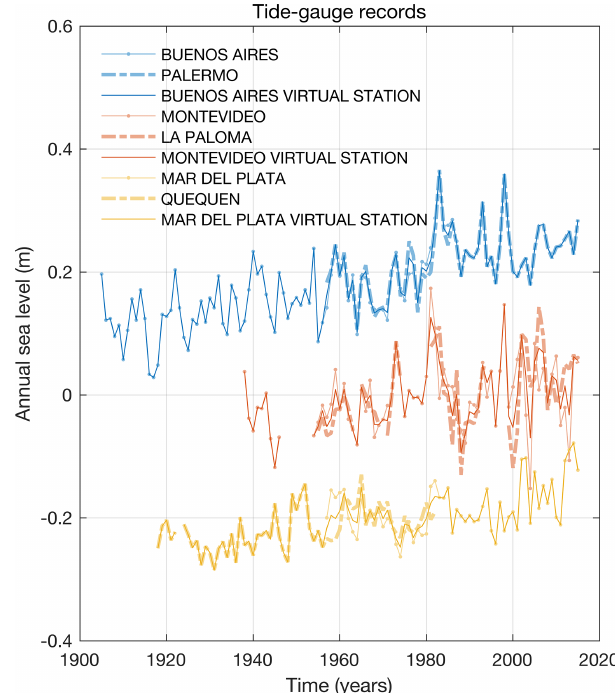
Figure 4. Yearly tide-gauge relative sea-level records (Fig. 1, Ta- ble 2). Virtual station time series are shown as thick lines, and in- dividual tide-gauge records are shown as thin lines. The time series are shifted vertically by an arbitrary amount for ease of visualiza- tion.